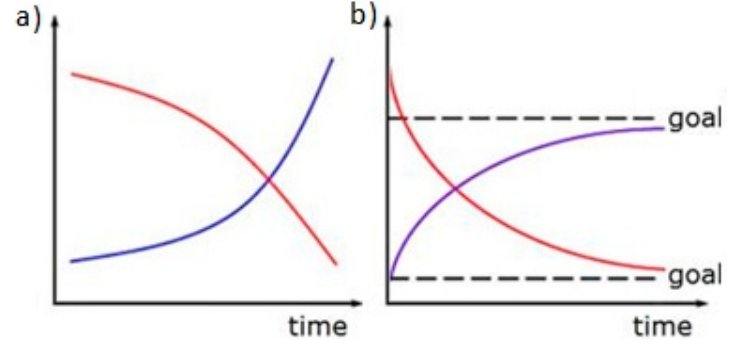
Figure 2. Temporal sequence charts of positive ( a ) and negative ( b ) feedback loops.